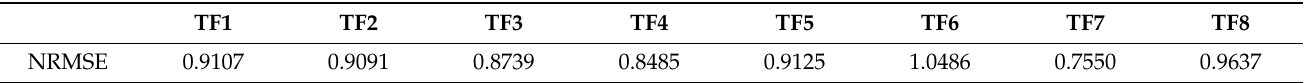
Table 8. NRMSE values comparing the accumulated lactate output values of the controller experiment one with the trajectory values using the goodnessOfFit function in MATLAB. The NRMSE closer to zero represents the better fit.